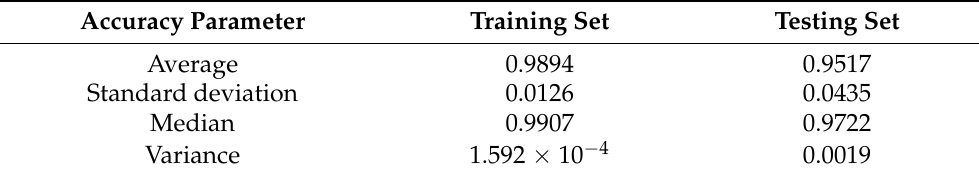
Table 2. Statistical properties computed over the 1000 randomized runs via the optimized DT